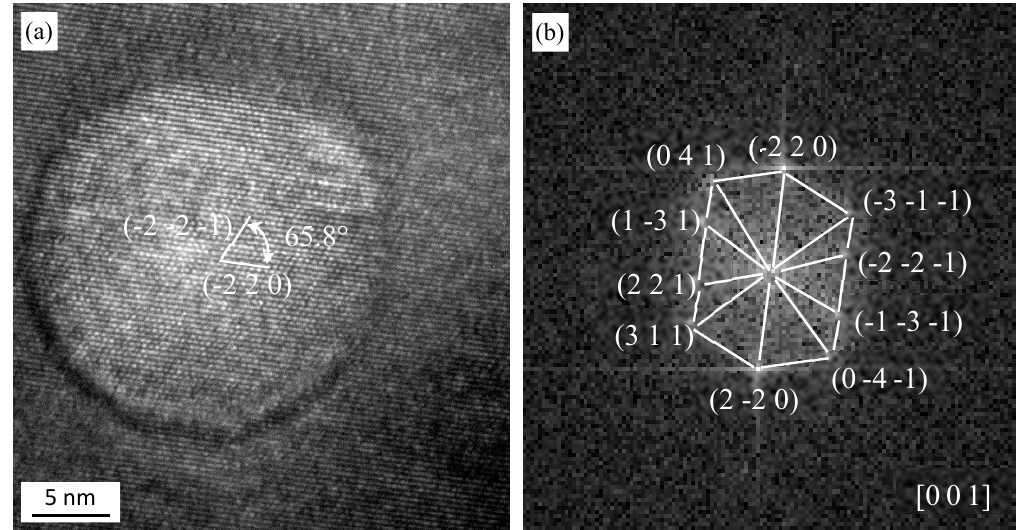
Figure 5. ( a ) HRTEM micrograph of Y 4 Zr 3 O 12 from a sample after TMP, ( b ) FFT (fast Fourier transform) diagram of the micrograph in ( a ).